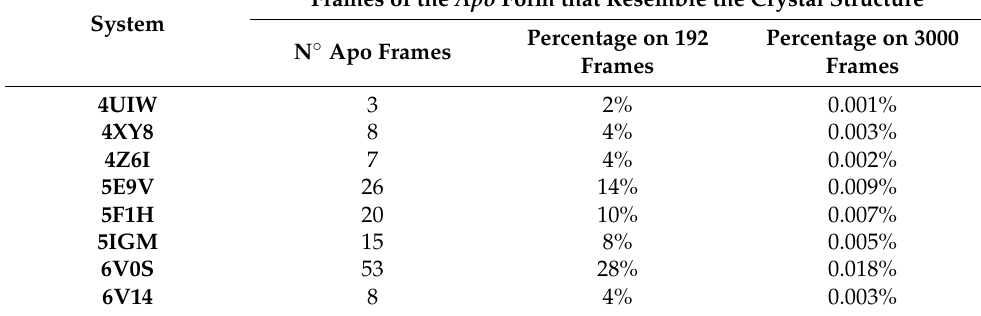
Table 3. The number of frames of the apo MDs that had an RMSD < 2.5 Å from the ligand/protein BRD9 structure was indicated with the related PDB code. The percentage is calculated considering both the 192 filtered frames (see text for details) and the total frames